Question: Which visualization type does this figure use?
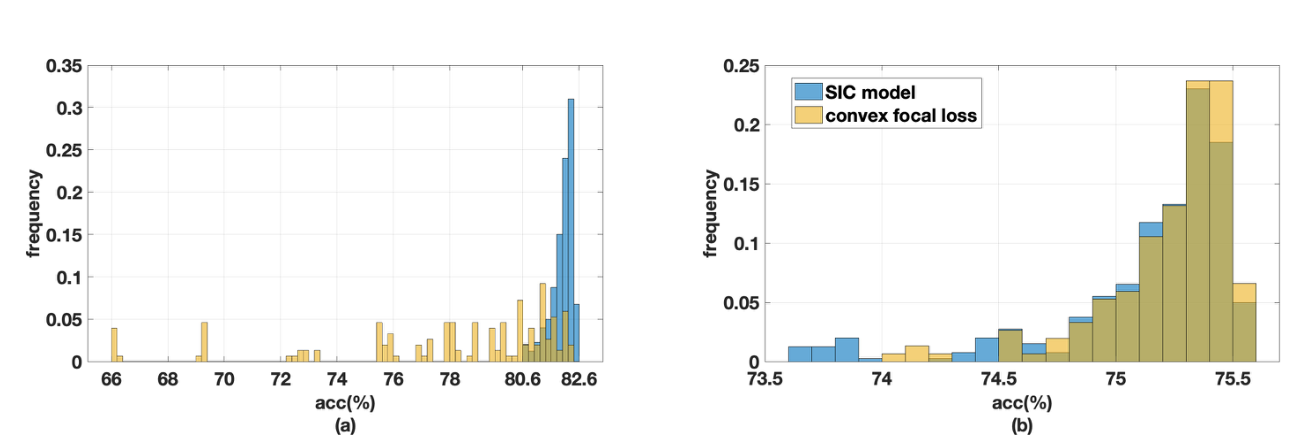
Answer: histogram